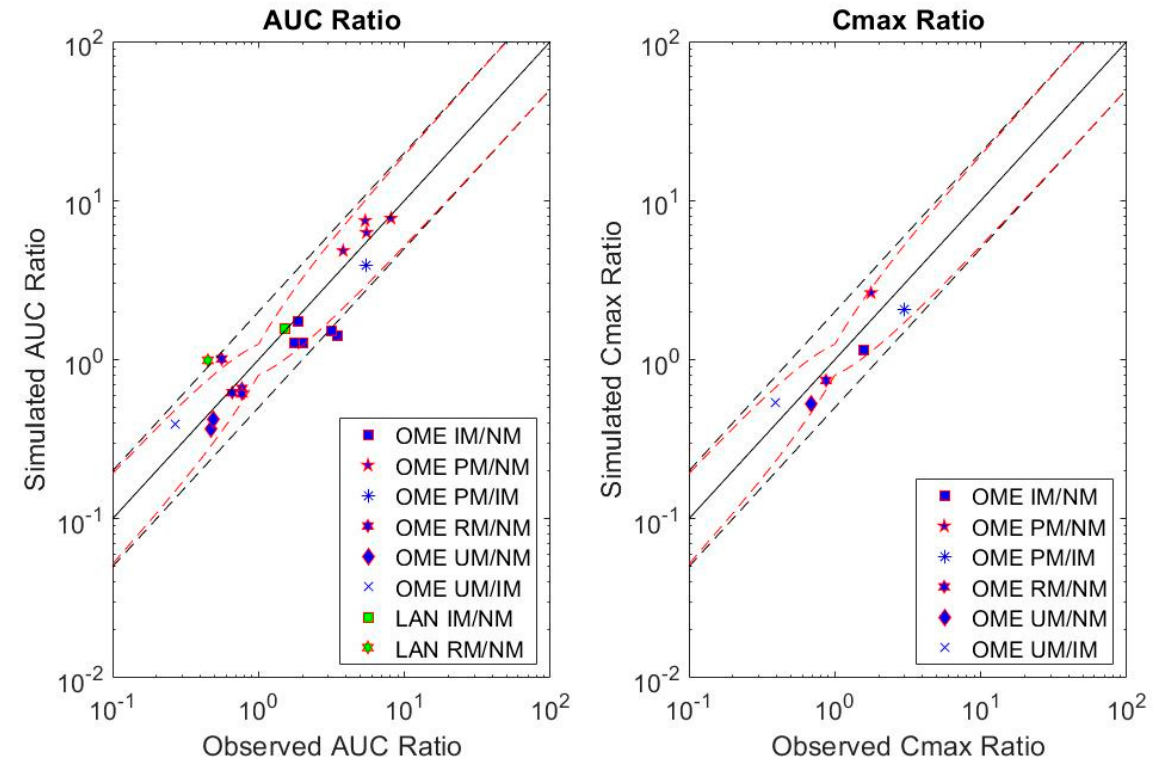
Figure 3. Simulated versus observed mean relative changes in exposure between CYP2C19 pheno- types for select omeprazole (OME) and lansoprazole (LAN) studies [18,19,26,33,40]. The solid black line is the line of unity, black dashed lines indicate 2-fold upper and lower acceptance criteria and red dashed lines indicate acceptance criteria suggested by Guest et al. [58].